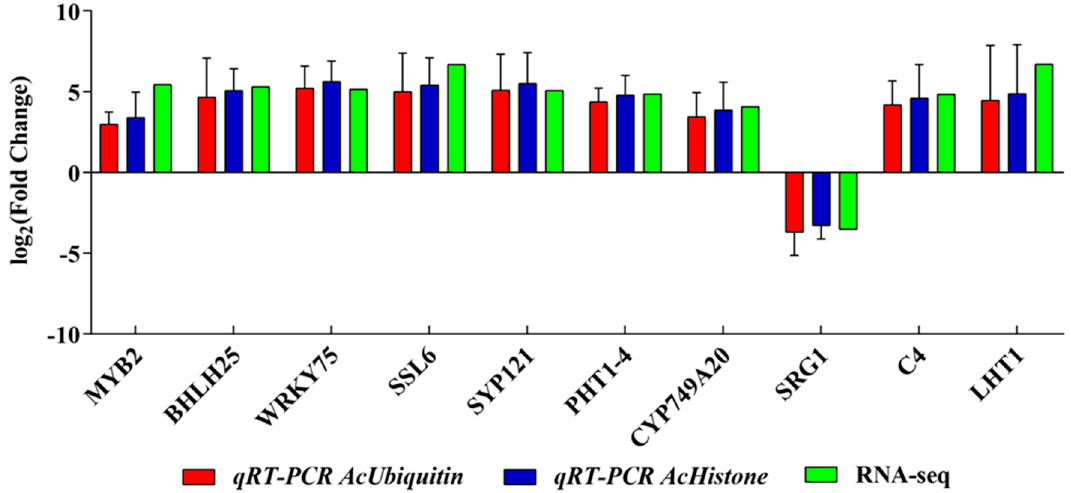
Figure 5. qRT − PCR analysis of the expression levels of ten DEGs in the TA and UA. The AcUbiquitin and AcHistone genes were used as the internal controls.